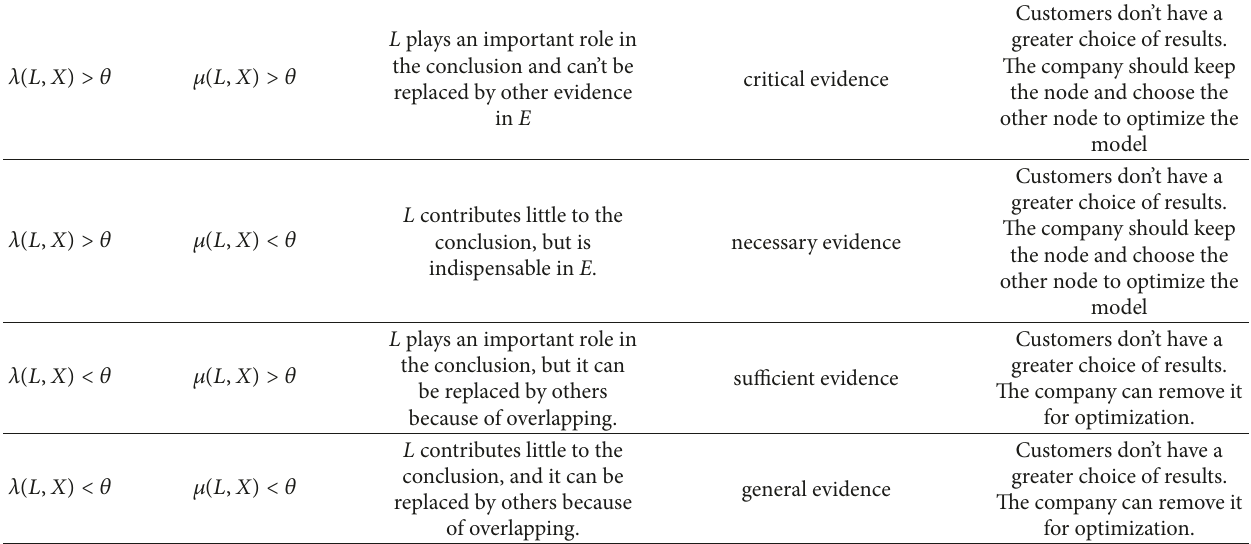
Table 3: The effect of evidence on inference